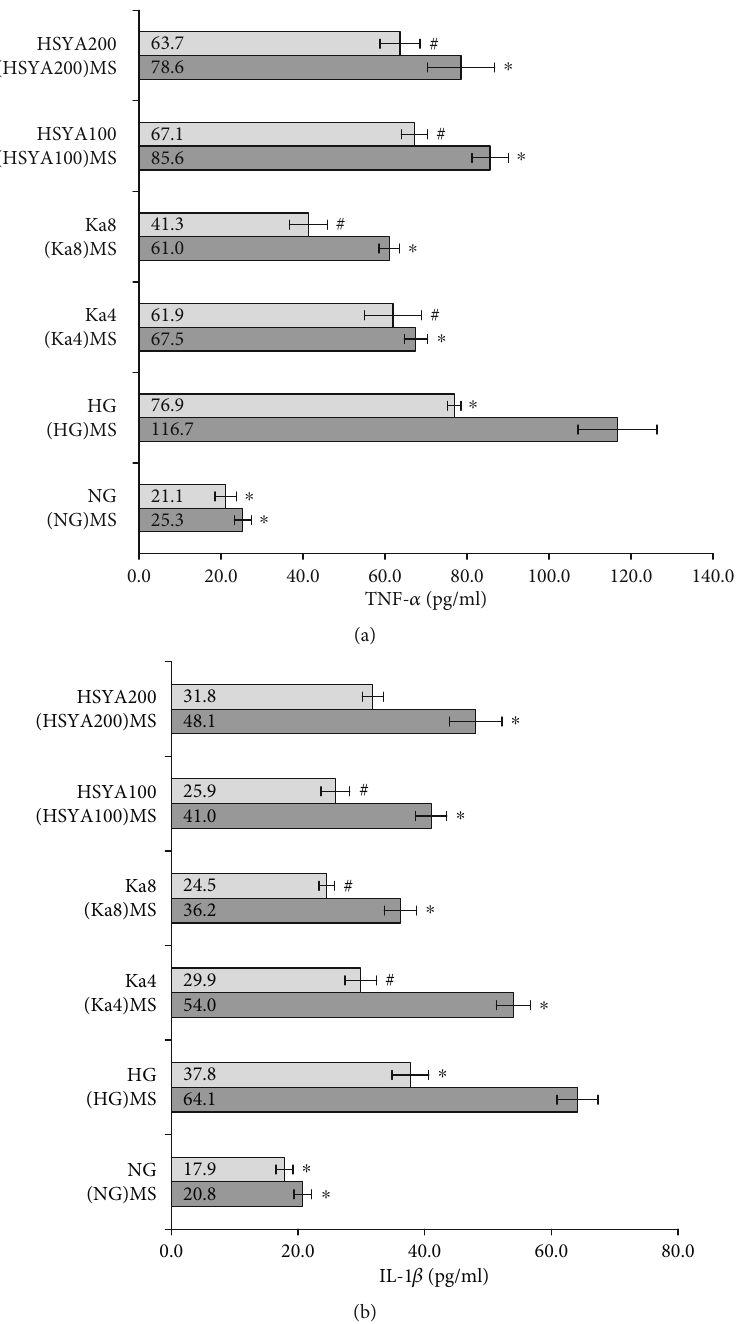
Figure 5: Determination of TNF- α and IL-1 β levels in podocytes. (a) TNF- α level. (b) IL-1 β level. Values were expressed as mean ± standard errorof themean ( n = 6 ). ∗ p < 0 : 05 versus (HG)MS. # p < 0 : 05 versus HG. Abbreviations: TNF- α : tumor necrosis factor- α ; IL-1 β : interleukin-1 β ; NG: 11.1 mM glucose; HG: 33.3mM glucose; Ka4: kaempferol 4 μ M in HG; Ka8: kaempferol 8 μ M in HG; HSYA100: hydroxysa ffl or yellow A 100 μ M in HG; HSYA200: hydroxysa ffl or yellow A 200 μ M in HG; (NG) MS: the supernatants from NG-cultured macrophage; (HG) MS: the supernatants from HG-cultured macrophage; (Ka4) MS: the supernatants from kaempferol 4 μ M and HG- cultured macrophage: (Ka8) MS: the supernatants from kaempferol 8 μ M and HG-cultured macrophage; (HSYA100) MS: the supernatants from hydroxysa ffl or yellow A 100 μ M and HG-cultured macrophage; (HSYA200) MS: the supernatants from hydroxysa ffl or yellow A 200 μ M and HG-cultured